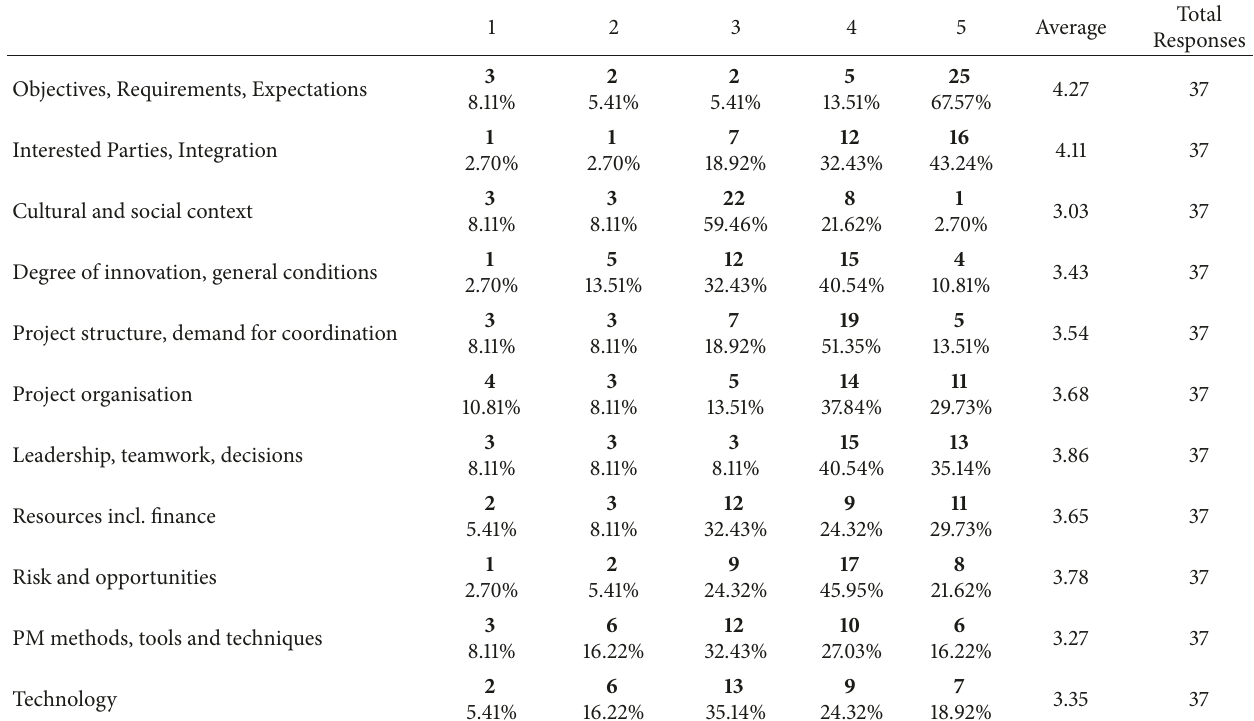
Table 3: Complexity groups, importance in IT